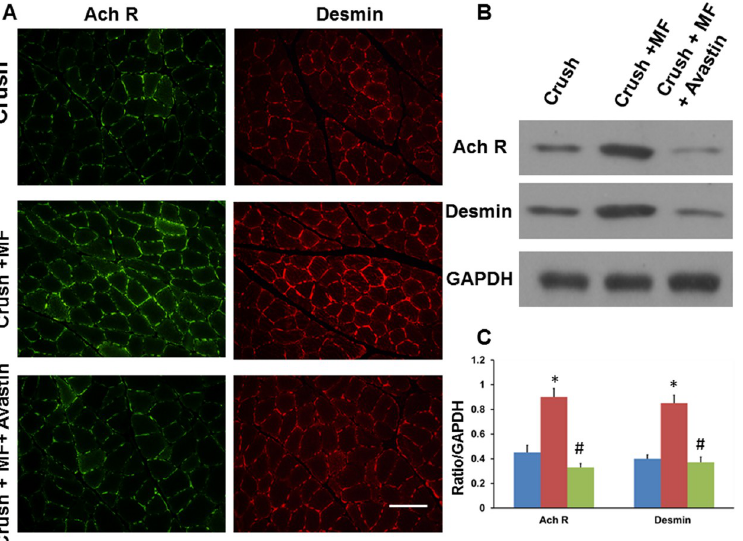
Fig 7. Restoration of morphology in denervated muscle in the crushed nerve wrapped by muscle flap rotation. (A) A representative example of a denervated muscle showing the expression of acetylcholine receptor and desmin in various treatment groups. (B) A representative example of western blot showing expression of acetylcholine receptor and desmin in the various treatment groups. (C) Quantitative analysis of acetylcholine receptor and desmin in the various treatment groups. Crush, Crush+MF, Crush+MF+Avastin: see text. � p < 0.05, �� p < 0.01 indicated the Crush +MF related to Crush, # p < 0.05 indicated Crush+MF+Avastin related to Crush+MF. Arrow bar length = 100 μ m.